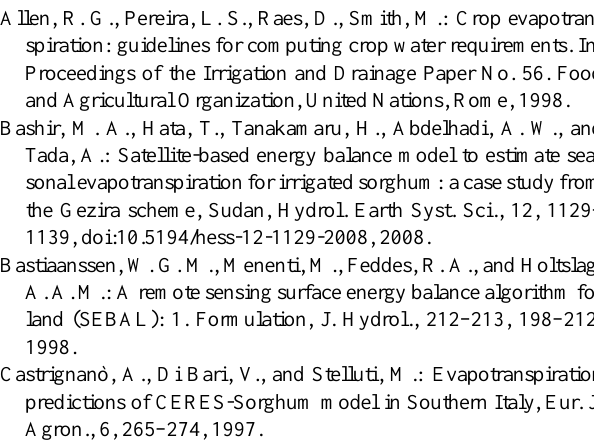
Figure 8. Cumulative modelled (STSEB) and measured (lys) sorghum ET. Cumulative 3 Fig. 8. Cumulative modelled (STSEB) and measured (lys) sorghum rainfall and irrigation applied is also plotted. 4 ET. Cumulative rainfall and irrigation applied is also